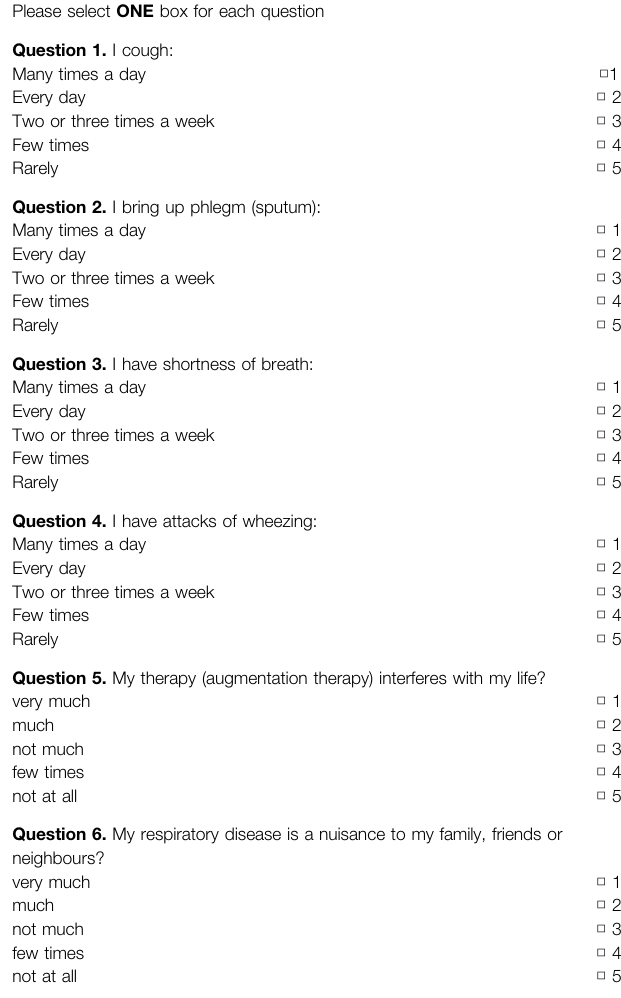
TABLE 1 | Questions extracted from SGRQ (St. George Respiratory Questionnaire) to calculate simpli fi ed QoL scores. Please select ONE box for each